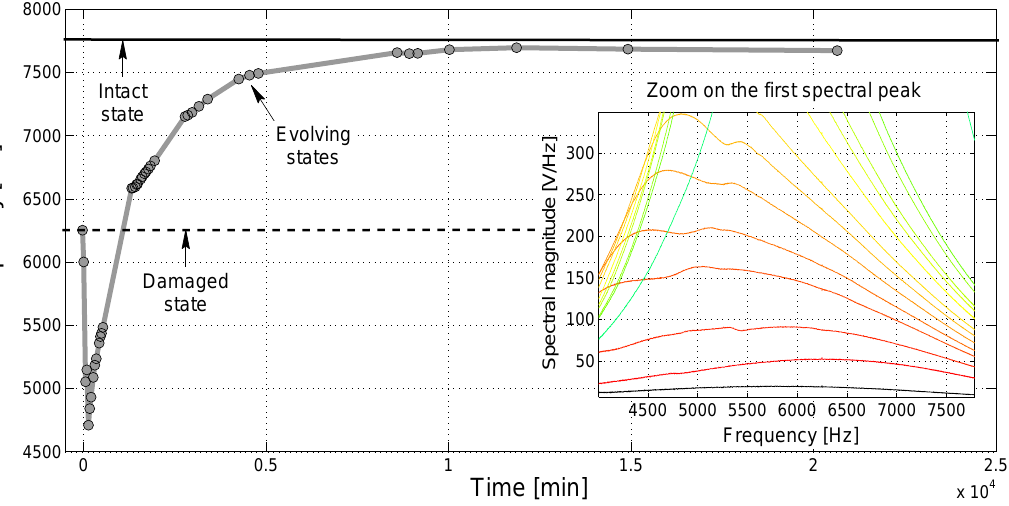
Figure 3. Resonance frequency of the first longitudinal mode as a function of time detected with a sweep source. Data refer to Specimen No.